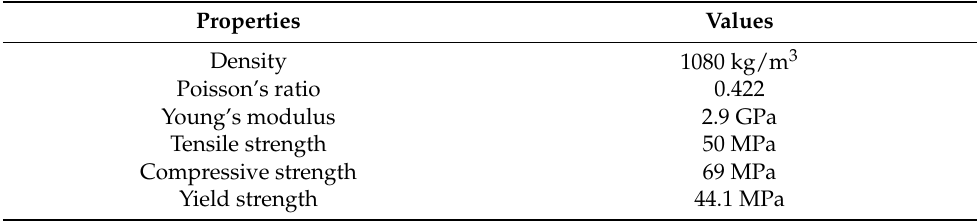
Figure 4. Design and non-design spaces. 2.1. Finite Element Analysis ANSYS DesignModeler is utilized for obtaining the basic geometry of the solid do- main. For better discretization of the design space, meshing is done using block meshing in the ANSYS ICEM CFD platform instead of an automatic mesh generation tool. The meshed CAD geometry is divided into a total of 424,430 hexahedral elements. ABS is used as the material and finite element analysis is carried out for evaluating the values of de- formation and stress concentration. Only one displacement boundary condition is given, i.e., a fixed boundary condition at the center of the frame. Thrust forces are applied at each of the four propeller slots (Figure 5). The results of FE analysis (Figures 6 and 7) show a minimum displacement of 4 µm and a maximum von Mises stress of 0.1 MPa (Table 2). Figure 5. Description of load and supports.